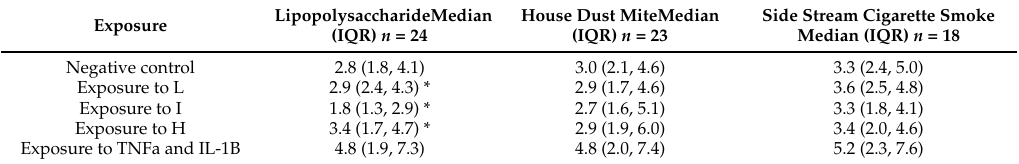
Table 3. Median and interquartile range (IQR) concentrations of vascular endothelial growth factor in supernatants from bronchial airway epithelial cell culture after exposure to lipopolysaccharide (L = lowest concentration = 1 µ g/mL, I = intermediate concentration = 10 µ g/mL and highest concentration = 100 µ g/mL), house dust mite (L = lowest concentration = 5 µ g/mL, I = intermediate concentration = 25 µ g/mL and H = highest concentration = 50 µ g/mL) and side stream cigarette smoke (concentrations the same as for house dust mite).